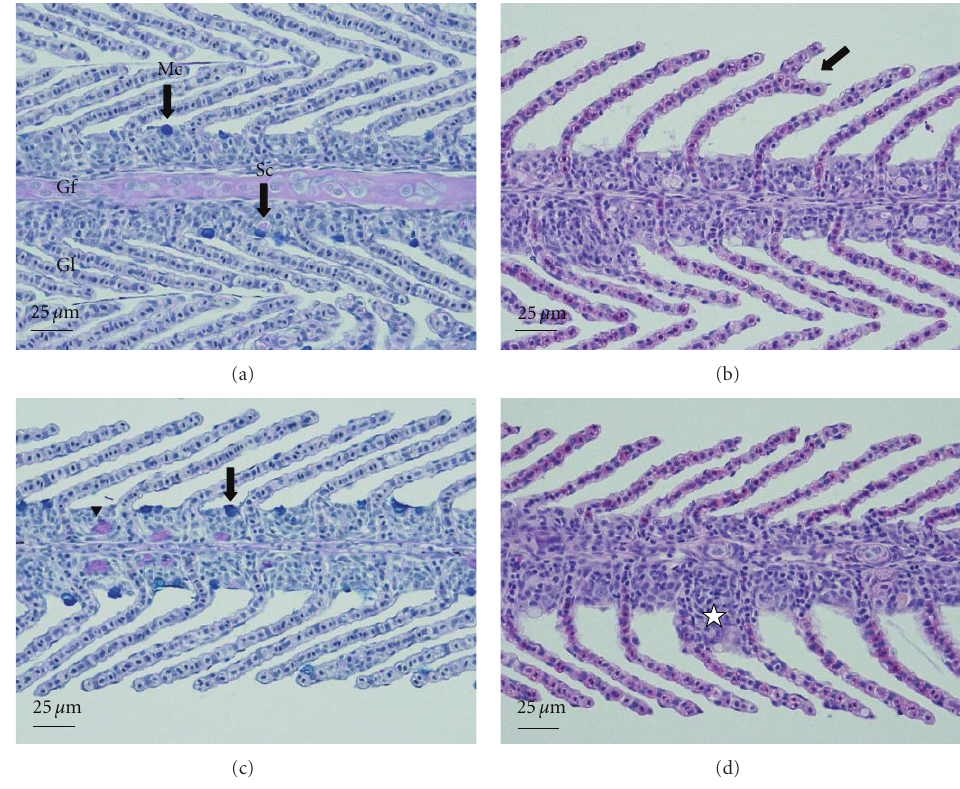
Figure 6: Histological changes in the gill of the common carp ( Cyprinus carpio ) exposed to Ag-NPs for 96h. (a) Control. Mc: mucous cell, Gf: gill filament, Gl: gill lamella, Sc: secretion cell. AB-PAS (pH 2.5) reaction. (b) 50 µ g/L. Bifurcation of the filament. H&E stain. (c) 100 µ g/L. Increase in mucous cells. AB-PAS (pH 2.5) reaction. (d) 200 µ g/L. Hyperplasia of the lamellar epithelium ( (cid:2) ). H&E